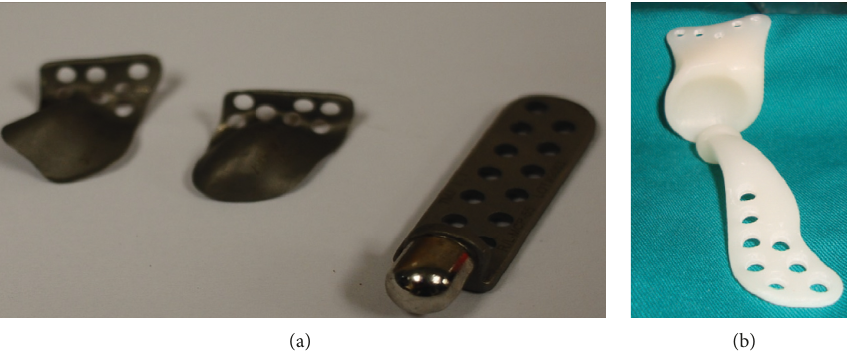
Figure 1: Stock and custom-made prostheses: (a) metal-on-metal (Cr-Co) Christensen ® prosthesis including 2 geometries of the glenoid fossa component and (b) customised Biomet-Lorenz ® prosthesis model on resin for evaluation prior to the surgical